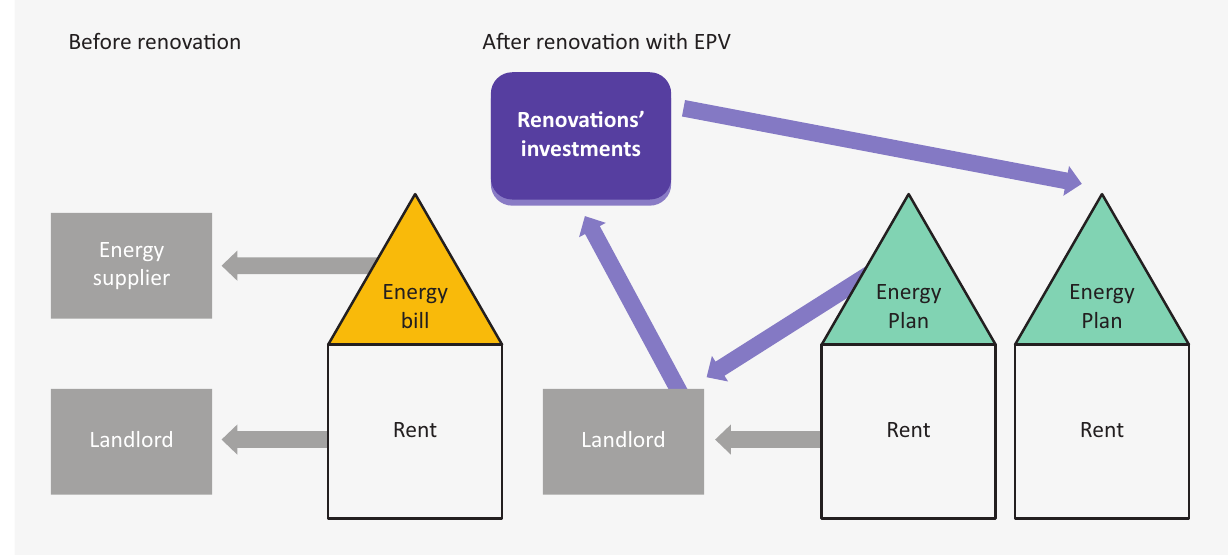
Figure 7. Economic model with